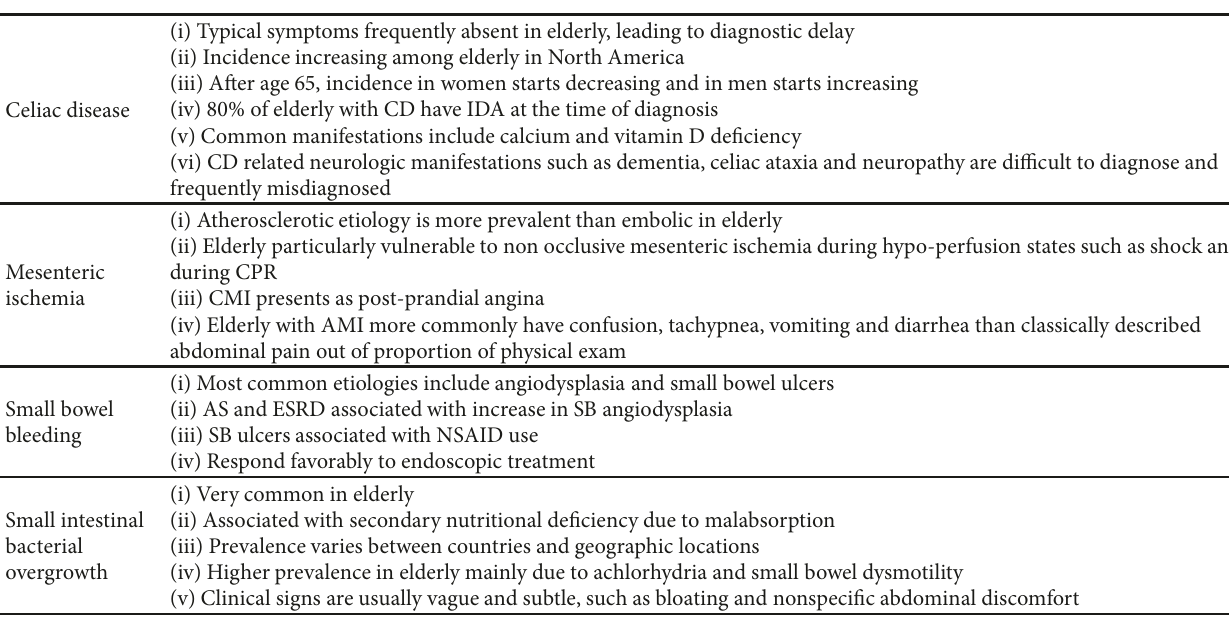
Table 4: Small bowel disease characteristics in older